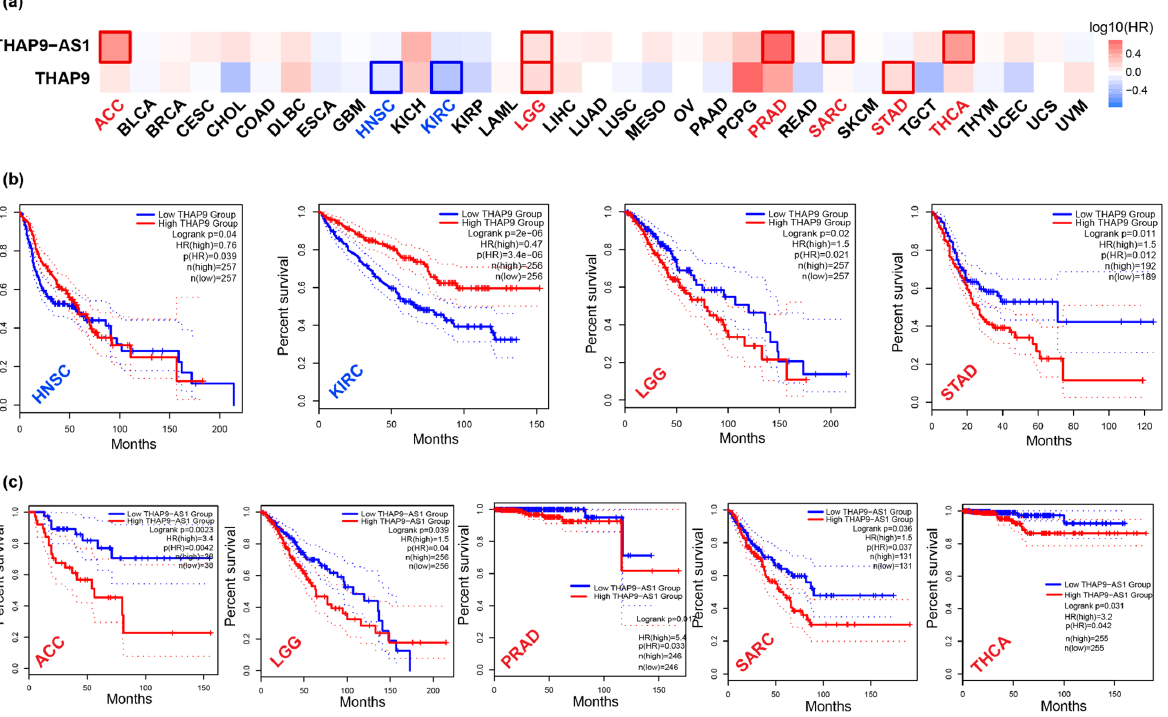
Figure 7. Overall patient survival analysis using GEPIA2. ( a ) The relationship between THAP9 and THAP9-AS1 gene expression and the overall survival prognosis of cancers in TCGA. Median was selected as a threshold for separating high-expression and low-expression cohorts. The red and blue blocks represent higher and lower risks, respectively, with an increase in gene expression. The bounding boxes depict the significant ( p < 0.05) unfavorable and favorable results, respectively. The overall survival and gene expression rates (from TCGA) of ( b ) THAP9 in HNSC, KIRC, LGG, and STAD; and of ( c ) THAP9-AS1 in ACC, LGG, PRAD, SARC, and THCA.